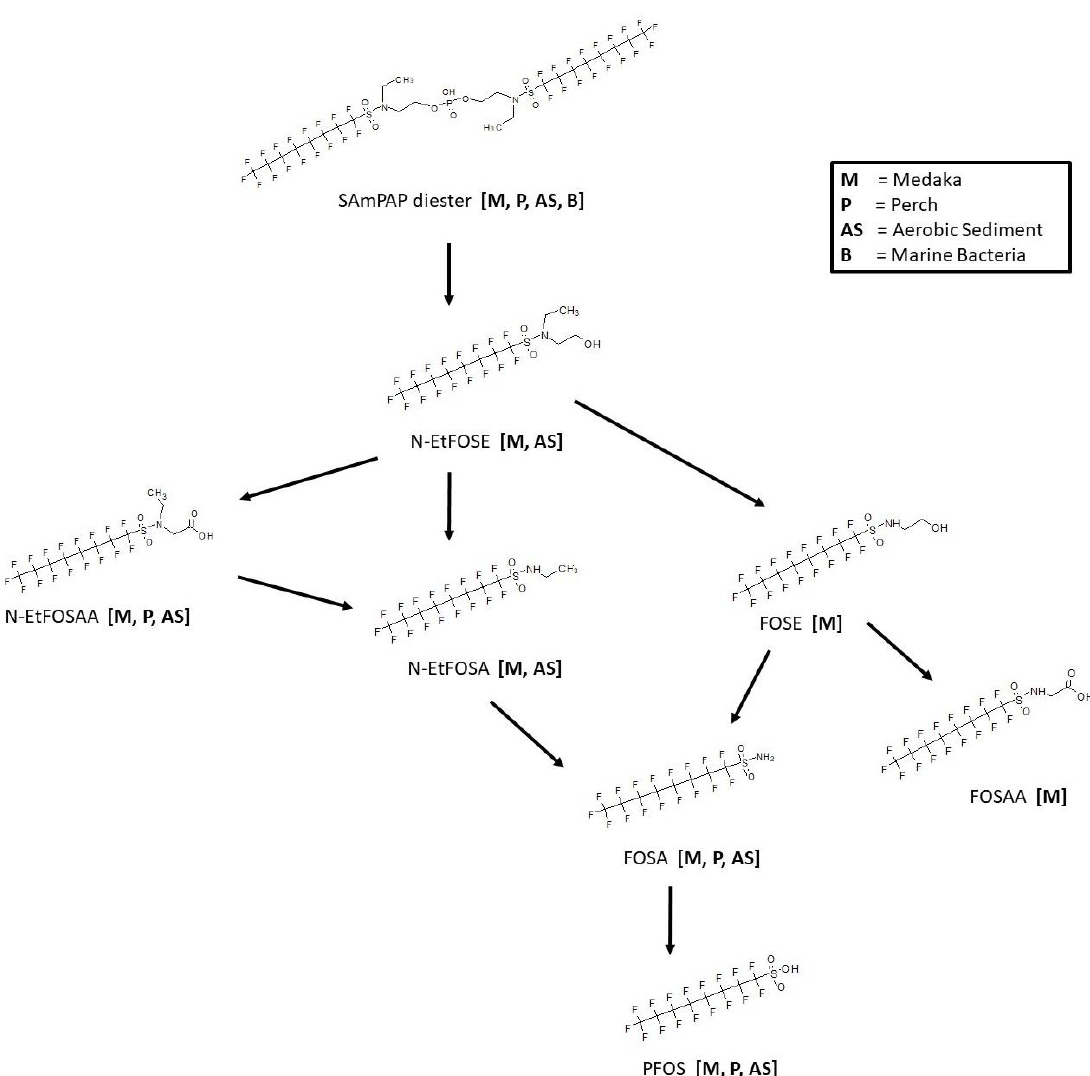
Figure 10. Metabolic map for SAmPAP diester as found in medaka [35], perch [36], aerobic sediment [37], and marine bacteria [38]. ment [37], and marine bacteria